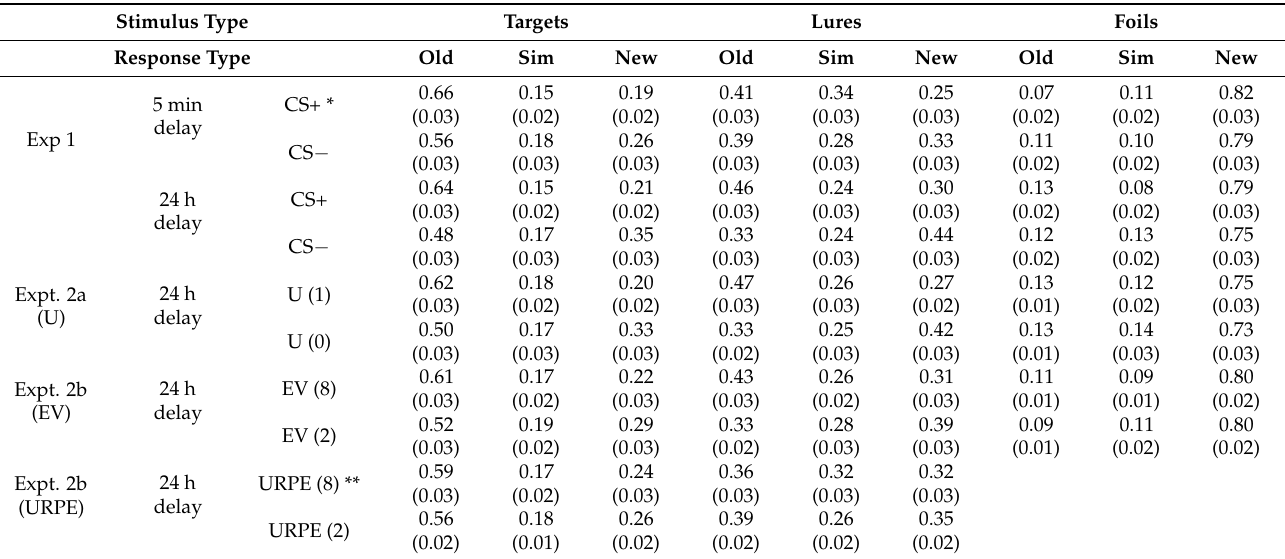
Table 2. The M ( SE ) of old, similar, and new responses were given to the target, lure, and foil items in different conditions in Experiments 1, 2a, and